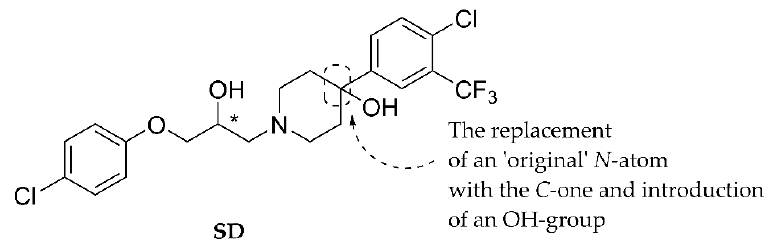
Figure 2. The highly lipophilic compound SD was efficient in vitro against Mycobacterium tubercu- losis H 37 R v . (* = chiral center) H 37 R v . (* = chiral